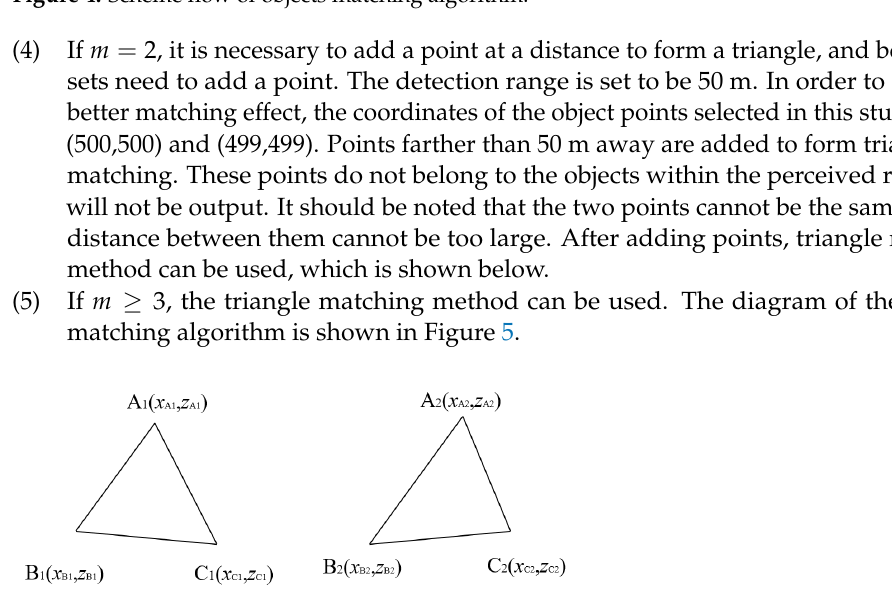
Figure 5. Objects matching algorithm:Diagram of triangle